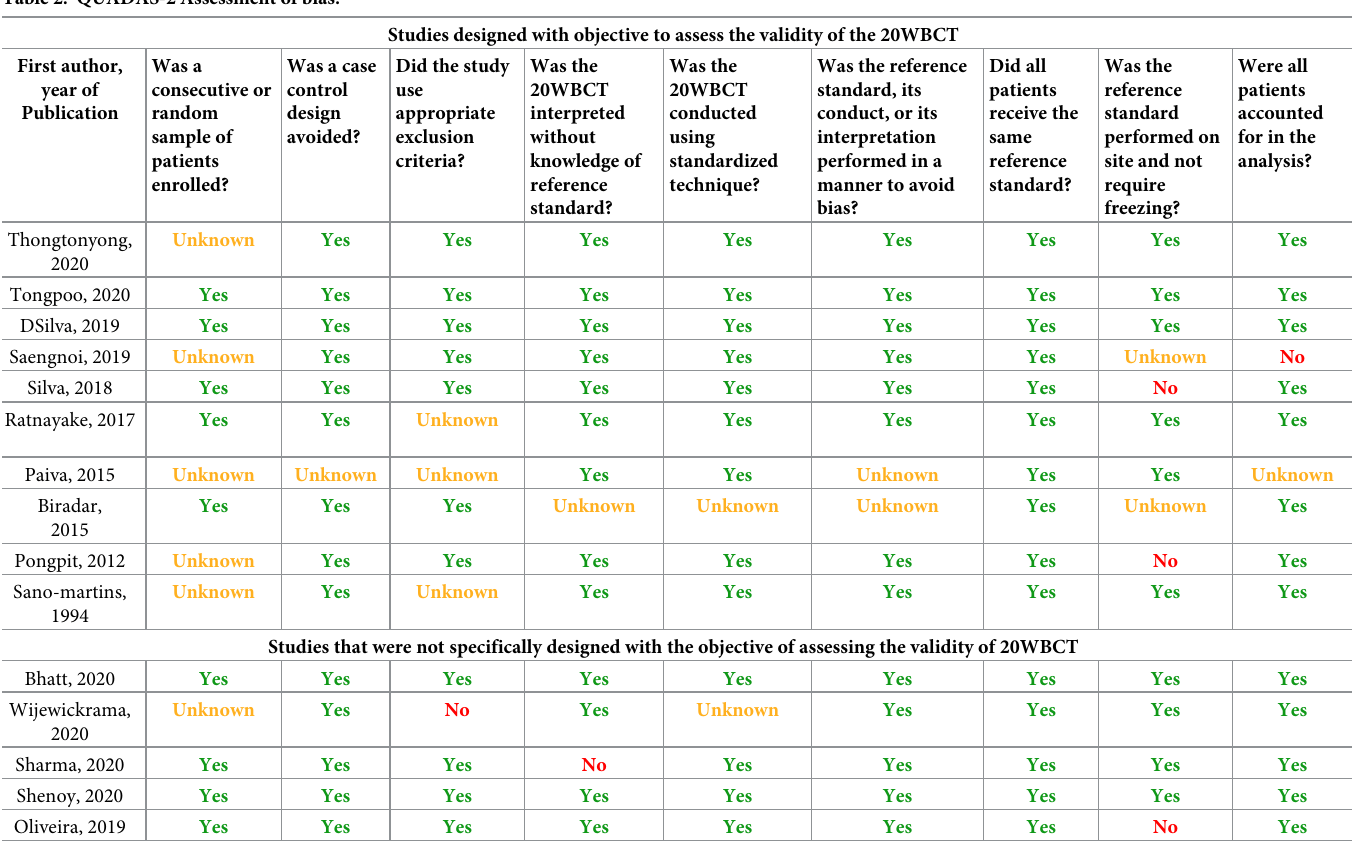
Table 2. QUADAS-2 Assessment of